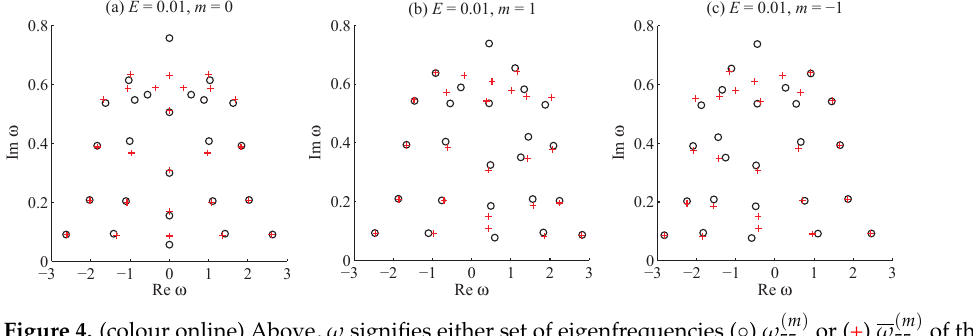
( m ) ( m ) E = 0.01, comparing the cases ( a ) m = 0 and M 55 for 55